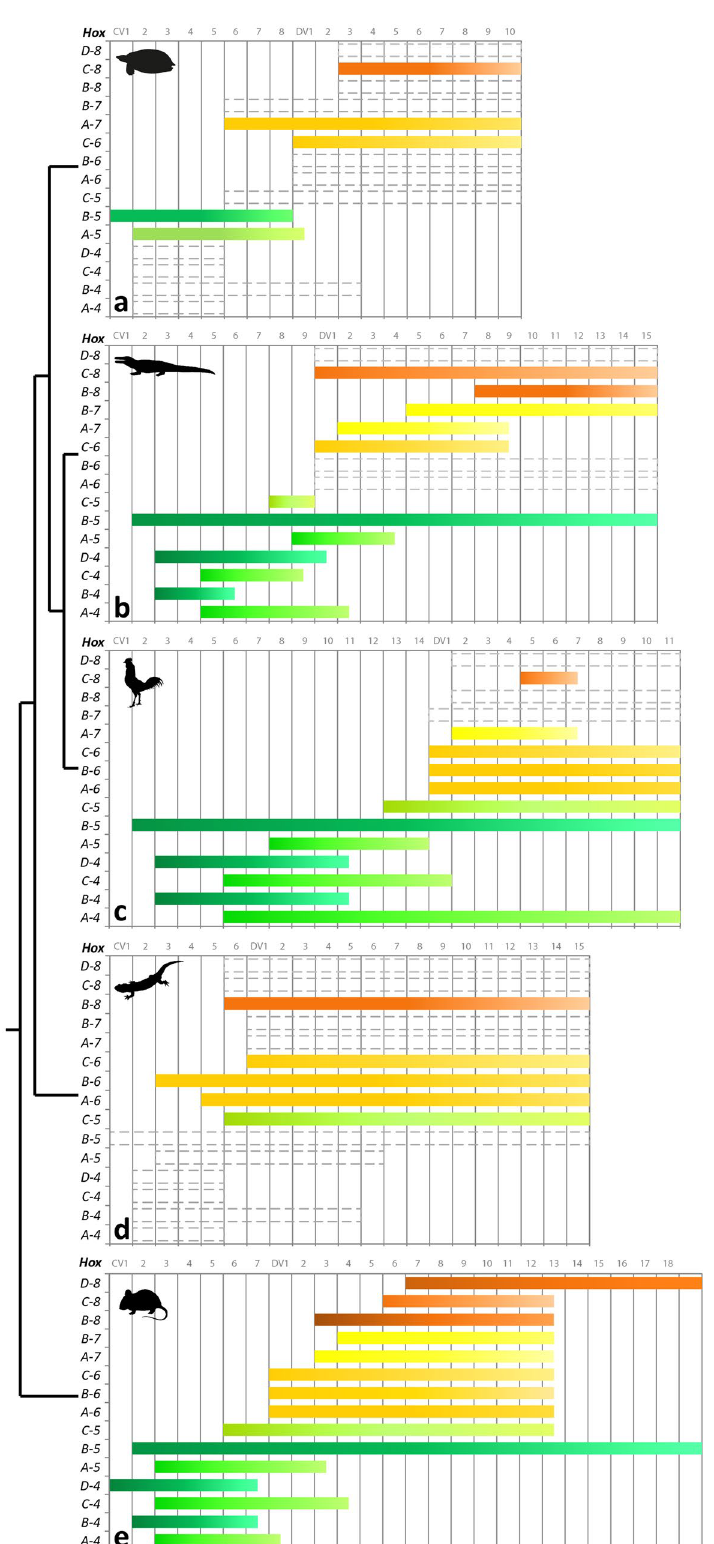
Figure 5. Summary of the somitic Hox code in amniotes. Modified from Böhmer et al . (2015a). Data for turtle ( a ) are based on Ohya et al . (2005) and for lizard ( d ) on Woltering et al . (2009). Information for crocodilians ( b ), chicken ( c ), and mouse ( e ) is based on Böhmer et al . (2015a). Anterior limits of expression are taken from determinations at relatively late stages. Posterior boundaries are not clearly